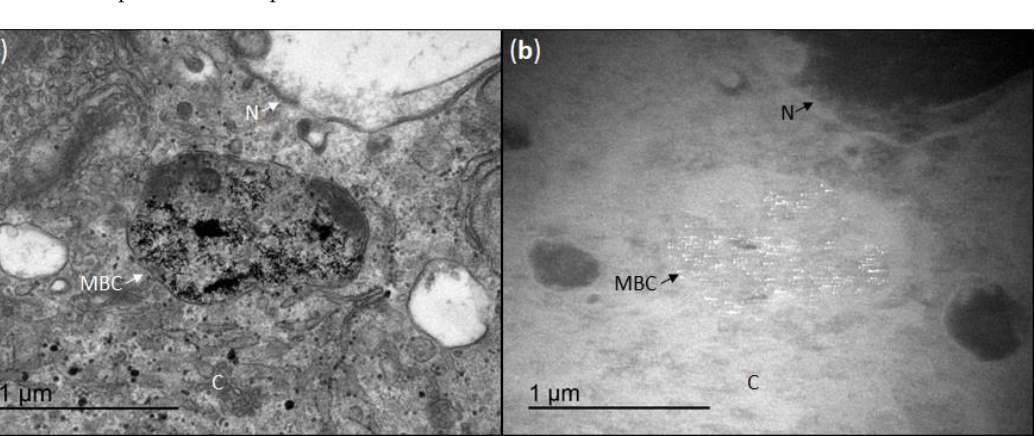
Figure 2. Cellular uptake of CeO 2 NPs. ( a ) Transmission electron microscopy image of CeO 2 NPs in HepG2 cells that were incubated for 24 h at a CeO 2 NPs concentration of 10 µg/mL; ( b ) the same image obtained under dark-field exposure, since the high contrast of the CeO 2 NPs allows them to be easily distinguished. MBC indicates a membrane-bound compartment, N the nucleus and C the